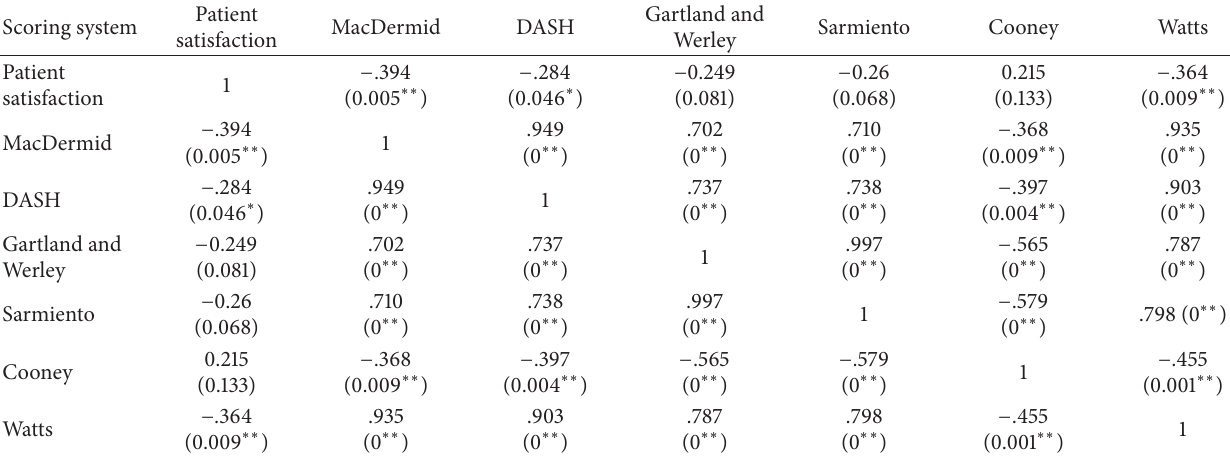
Table 3: Correlation matrix using Pearson correlation of patient satisfaction with six scoring systems (based on 50 observations). Scoring system